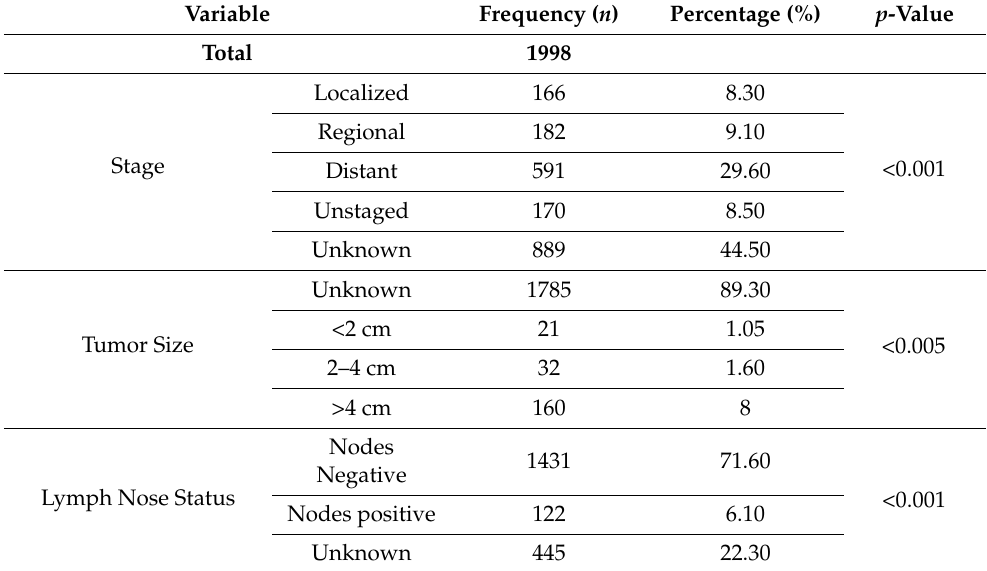
Table 3. Tumor stage, size, and lymph node characteristics of 1998 Patients with Primary Peritoneal Mesothelioma from the Surveillance, Epidemiology, and End Results (SEER) database, 1975–2016.